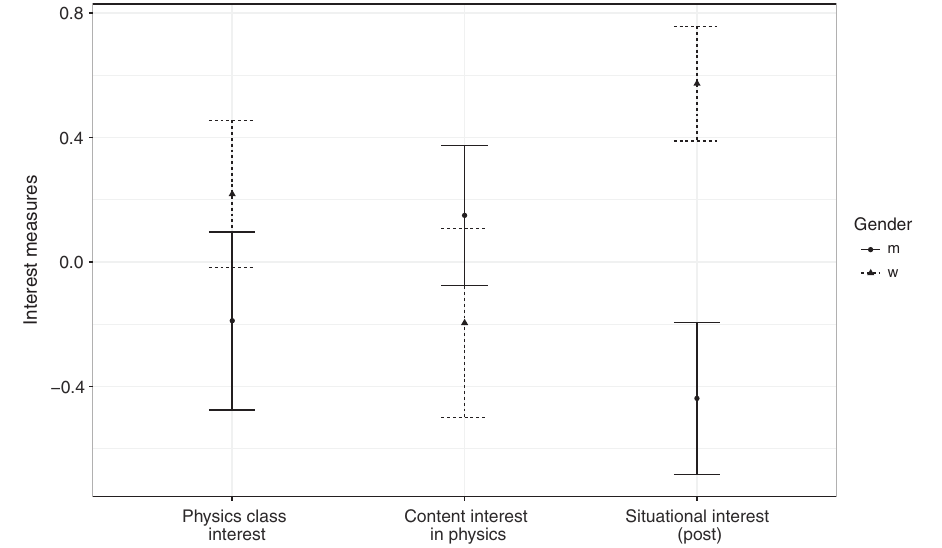
FIG. 3. Means and standard errors for interest measures with regards to gender differences (note that the variables are